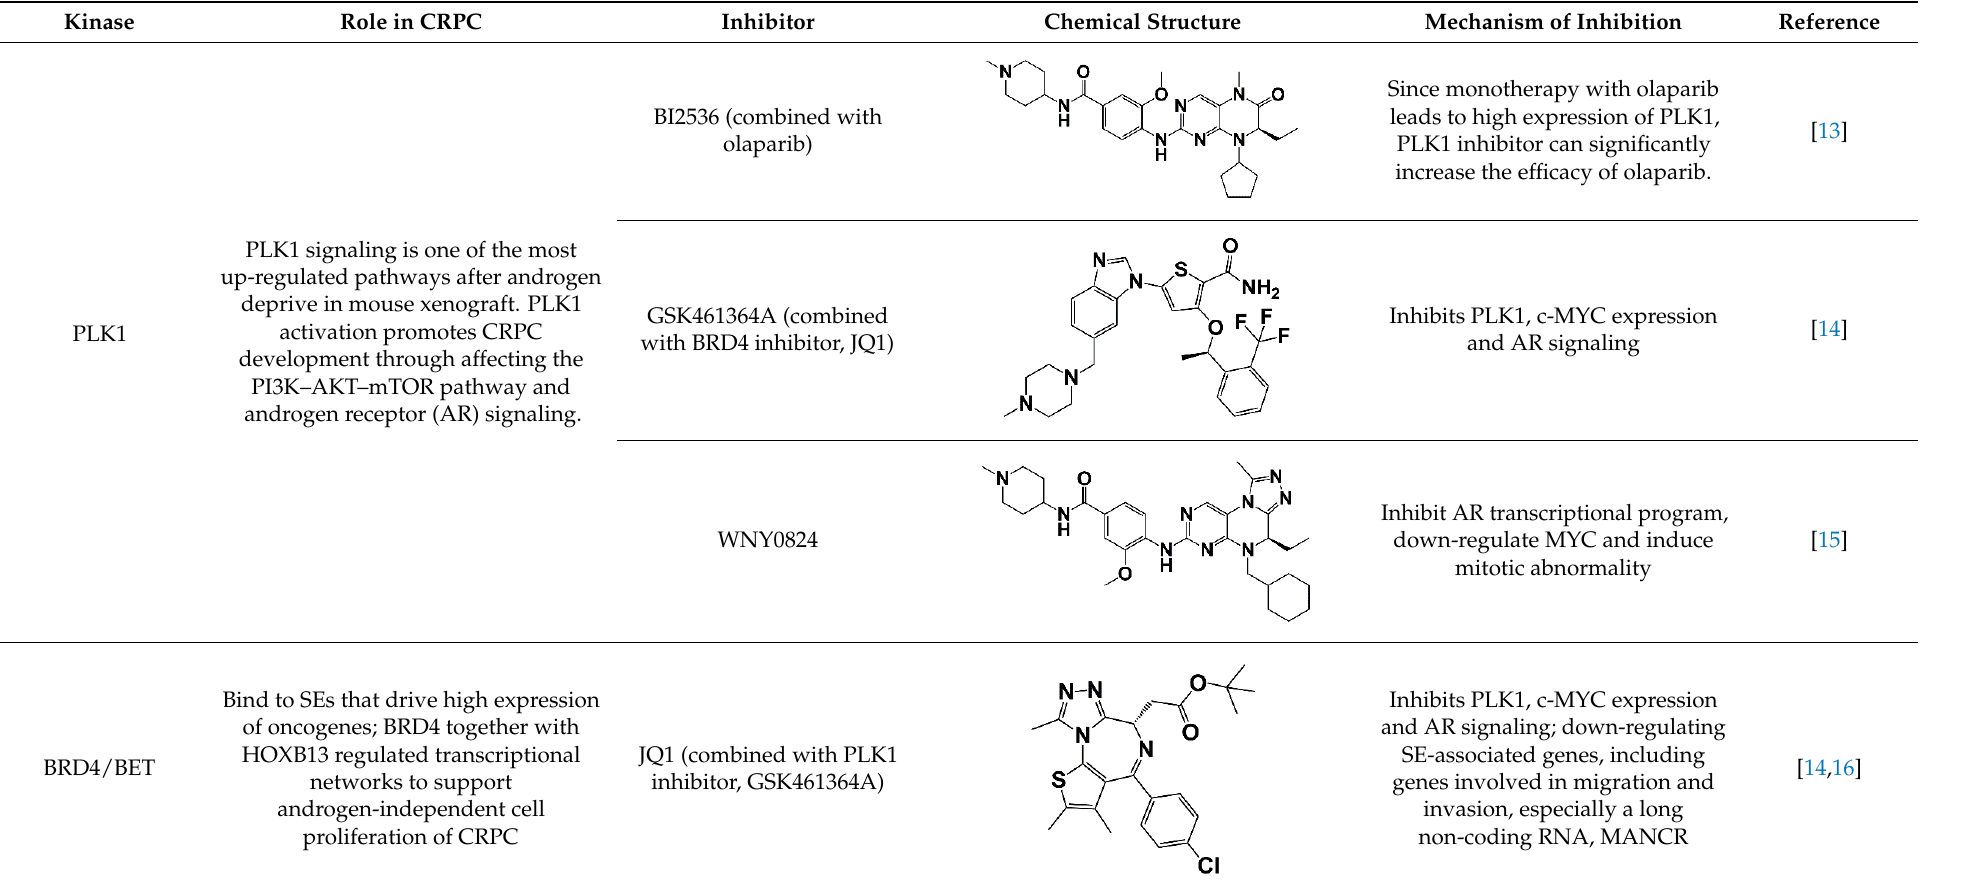
Table 1. Inhibitors target key kinases in CRPC.